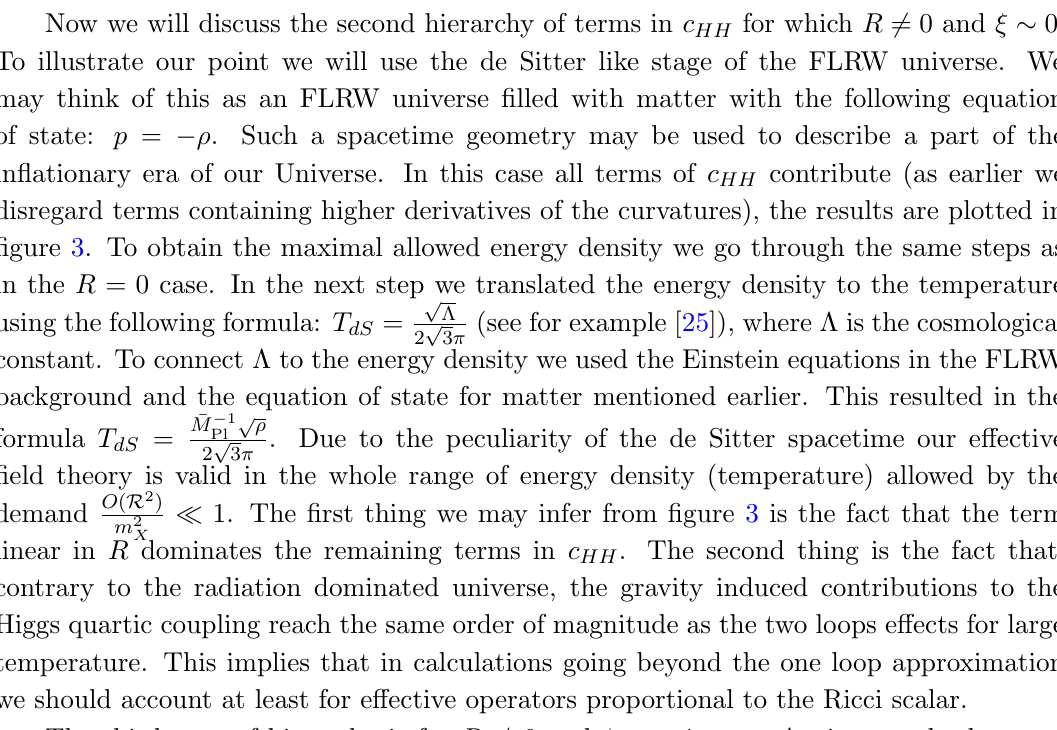
Figure 2 . The contribution of the gravity induced part of the c HH coe(cid:14)cient to the Higgs quartic coupling in the radiation dominated FLRW background. j c HH ( K ) j = j (cid:0) 1 the temperature and loops prefactors are given by the formula nloop= (cid:21) (cid:21) HX = 0 : 25, (cid:21) H = 0 : 13 and m X = 10TeV. The plot was made in the double logarithmic